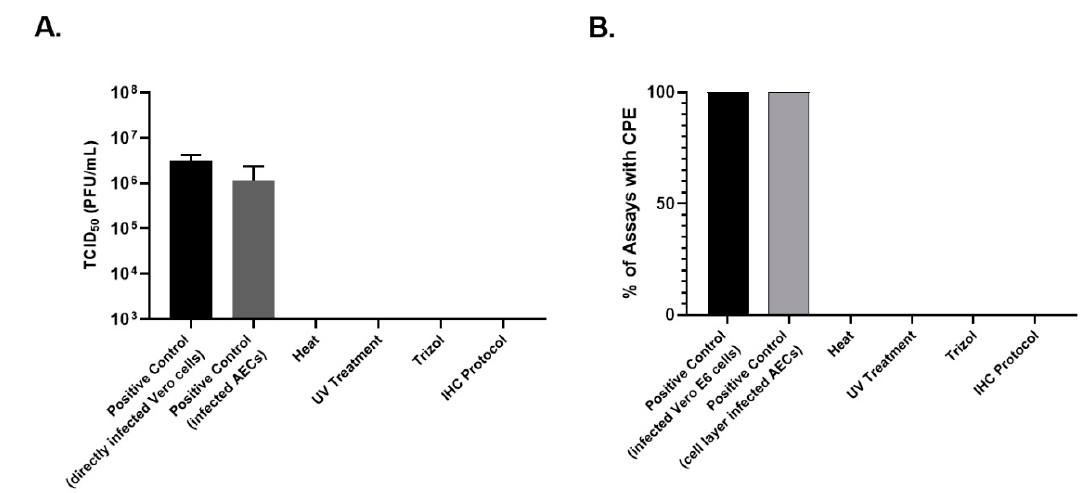
Figure 5. Summary of viral titers from 50% tissue culture infectious dose (TCID 50 ) assays Panel ( A ) and observed cytopathic effect (CPE) Panel ( B ) in SARS-CoV-2 infected Vero E6 cells, Vero cells exposed to SARS-CoV-2 infected AEC cell layer, SARS-CoV-2 exposed to heat (65 ◦ C) for 10 min, SARS-CoV-2 treated with UV light, RNA harvested with Trizol ® from SARS-CoV-2 infected AECs, and SARS-CoV-2 infected AECs fixed for immunohistochemistry (IHC) from SARS-CoV-2-infected AECs. Given that the protein isolation protocol tested (Triton X and SDS) resulted in direct toxicity with complete CPE at 10 − 1 dilution without SARS-CoV2 (see Figure 4A), this inactivation method is not included in this